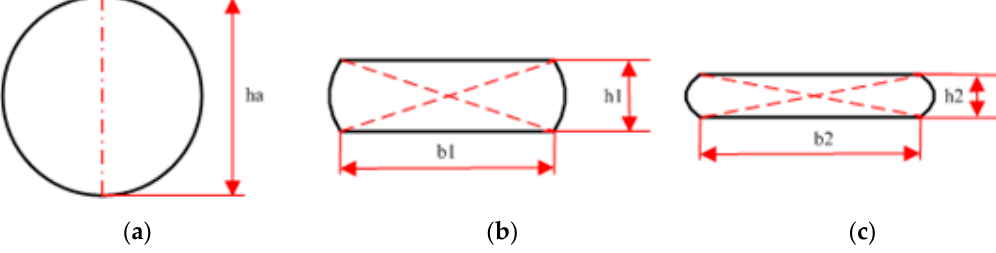
Figure 7. Schematic illustration of the effect of wire height reduction on shear bands. ( a ) Initial wire ( b ) rolled wire after Pass 1 ( c ) rolled wire after Pass 2.